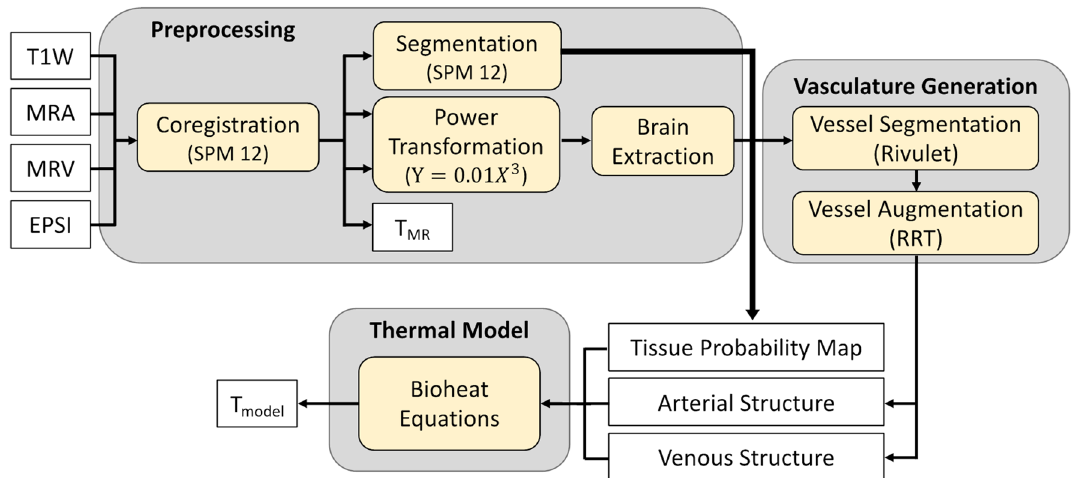
Figure 1. Overview of our subject-specific biophysical model used to generate personalized whole brain temperature maps. Input MR data (T1W, MRA, MRV) is acquired from each subject and used in the model. Model-predicted temperatures are compared to MR-measured temperatures acquired independently with MR thermometry using EPSI. T1W T1-weighted MR images, MRA MR angiography, MRV MR venography, EPSI echo planar spectroscopic imaging, RRT rapidly exploring random tree, T model Model-predicted brain temperature, T MR MR-measured brain